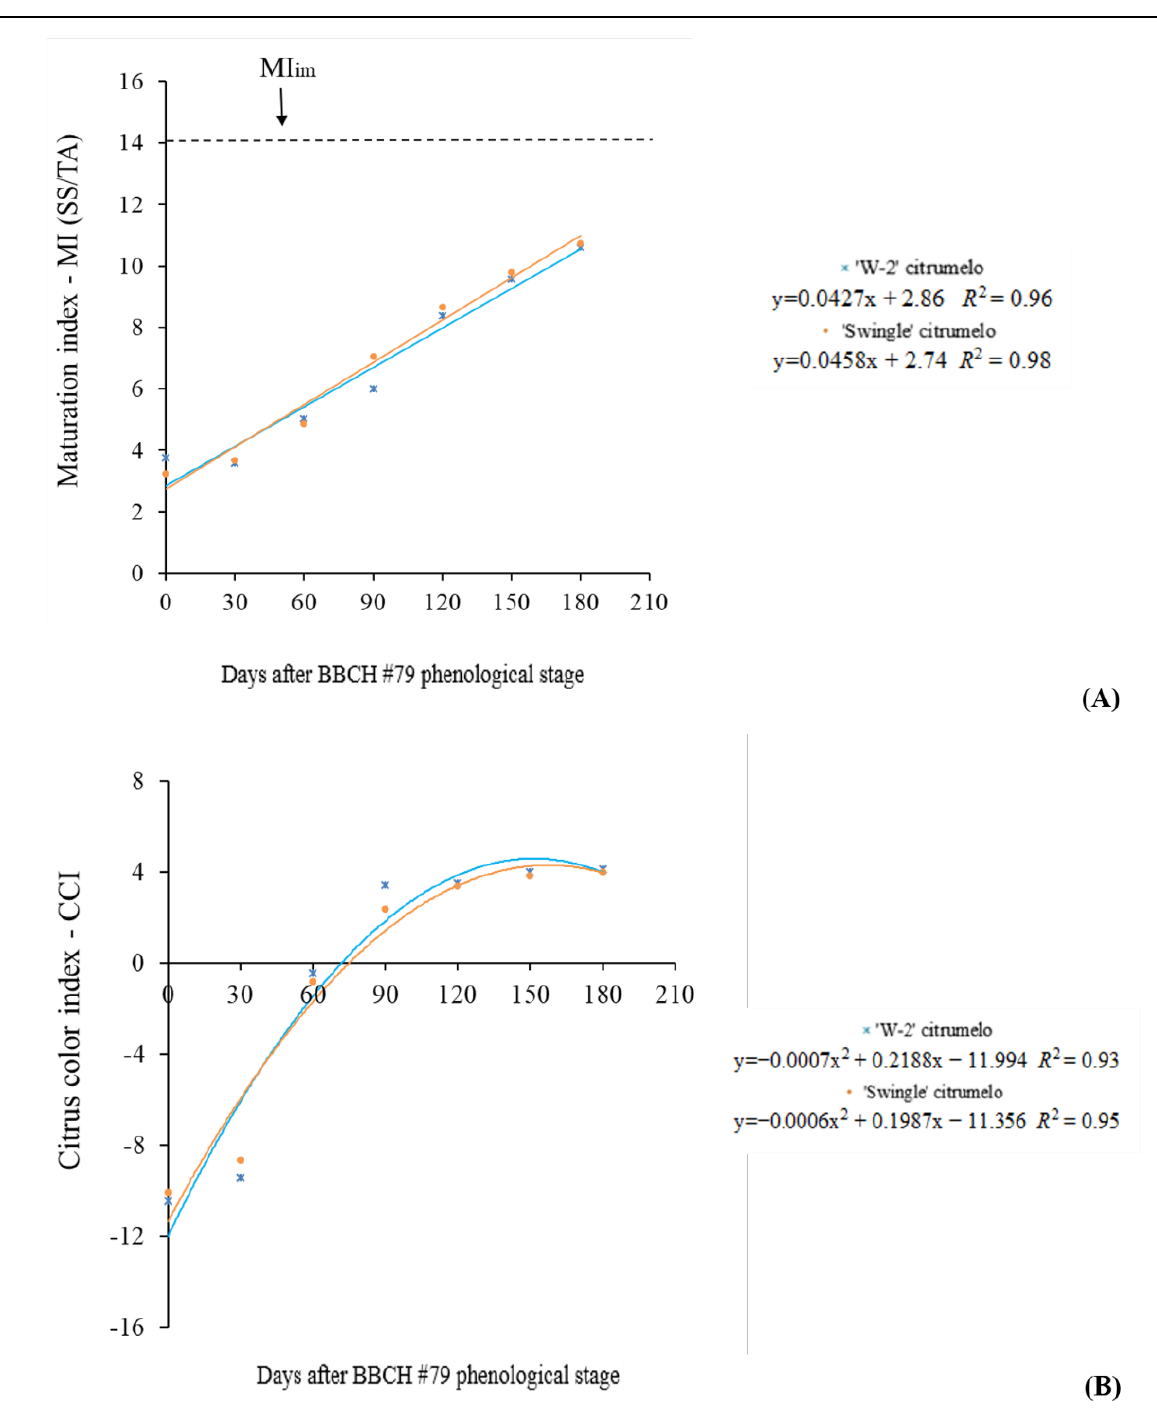
Figure 7. Development of ‘Valencia’ orange fruit ripening when trees are grafted on different ‘Trifoliata’ hybrid rootstocks at São Jerônimo da Serra. ( A ): maturation index (MI) or ratio (SS/TA); ( B ): citrus color index (CCI). MI im = ideal mean maturation index = 14. Phenological stage BBCH #79 (Meier, 2001), approximately to 200 days after flowering.